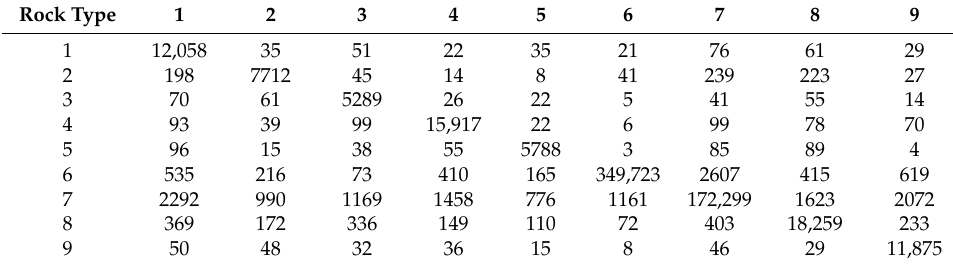
Table 6. Numbers of blocks with no evidence of misinterpretation (conditions +1 to +4) (diagonal line) and numbers of potentially misinterpreted blocks (condition +5) (off-diagonal) for each interpreted rock type (row) and each suggested rock type based on classification of 20 realisations